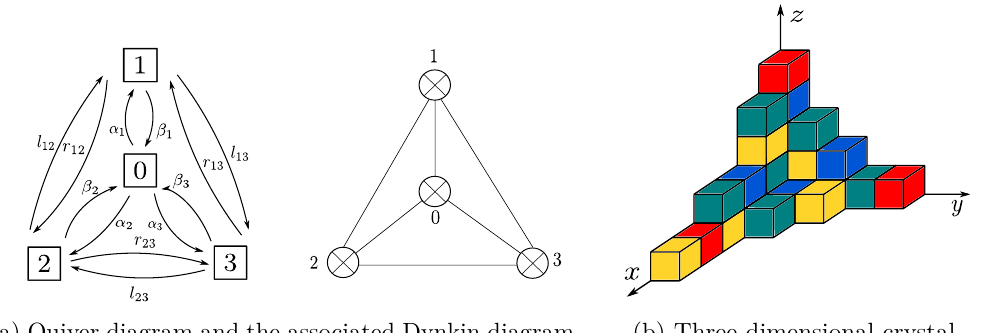
(a) Quiver diagram and the associated Dynkin diagram. Figure 39. Quiver diagram, Dynkin diagram, and three-dimensional crystal of C 3 / ( Z 2 × Z 2 ) [62]. The quiver diagram is the same as the Dynkin diagram of the affine superalgebra ˆ D (2 , 1; α ) (see figure 39(a)). The three-dimensional crystal is a plane partition, which is the same as the quantum toroidal gl , but the coloring is different. There are four colors: red, blue, yellow, and green. Each 1 of them corresponds to the four vertices of the quiver diagram. The origin box is